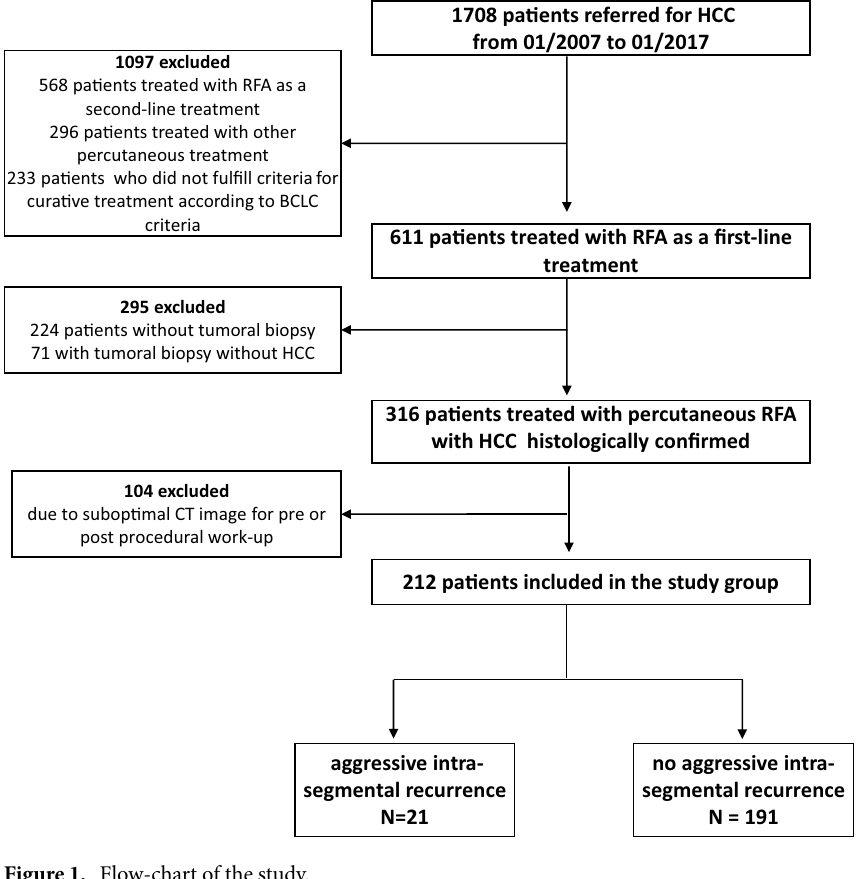
Figure 1. Flow-chart of the